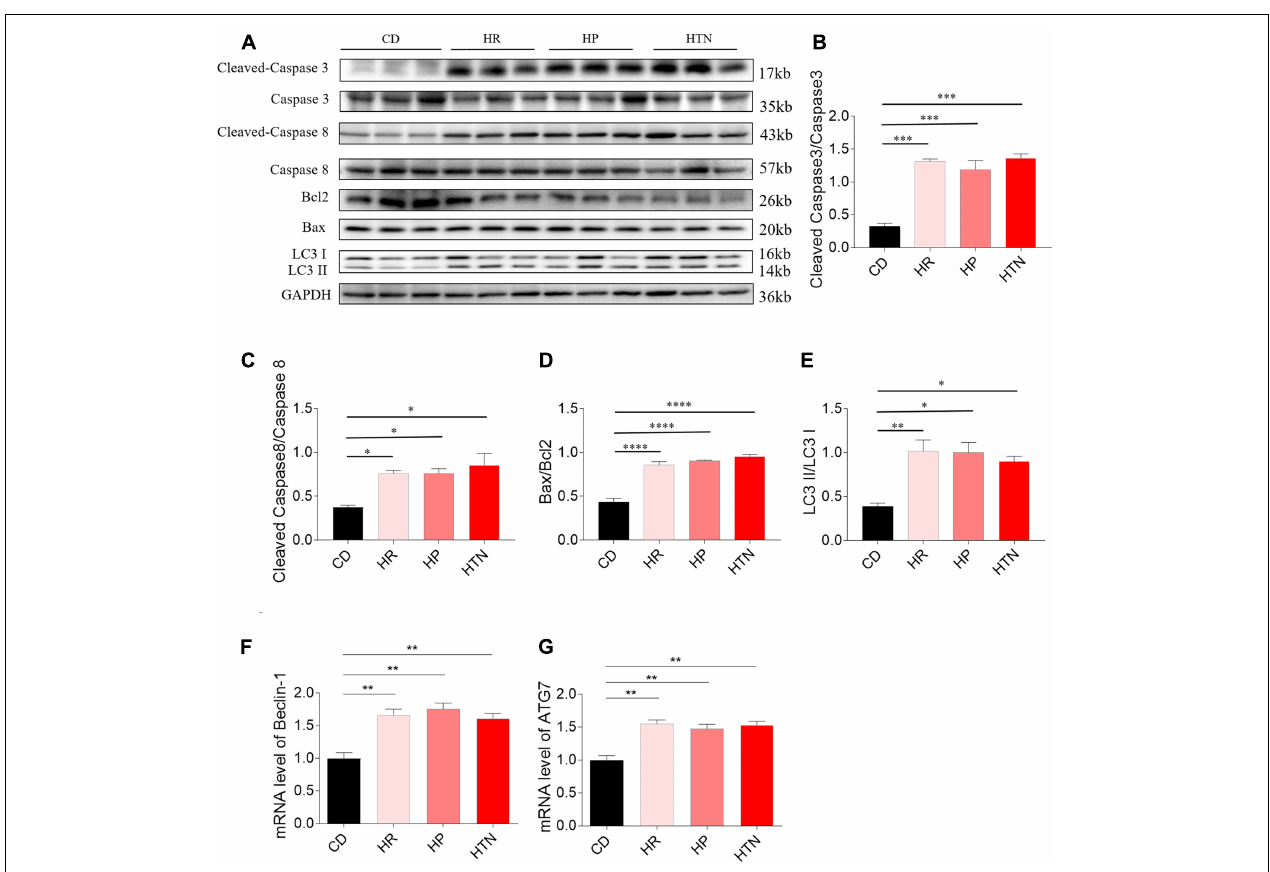
FIGURE 2 | Effects of high-salt diet (HSD) on apoptosis and autophagy in the heart of hypertension-resistant (HR), hypertension-prone (HP), and hypertension (HTN) rats. The expression levels of cleaved-caspase 3/caspase 3 (A,B) , cleaved-caspase 8/caspase 8 (A,C) , Bax/Bcl2 (A,D) , LC3 II/LC3 I (A,E) , Beclin-1 (F) and autophagy related 7 (ATG7) (G) were increased in the heart of HSD rats with HR, HP and HTN. The results are expressed as mean ± SEM; n = 6 in each group. * p < 0.05, ** p < 0.01, *** p < 0.001, and **** p < 0.0001.